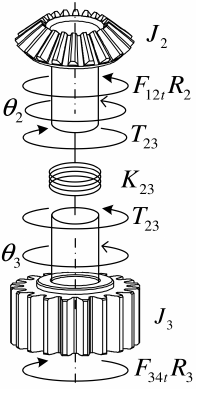
Figure 6. Coupling between the driven wheel of the LSPR and the